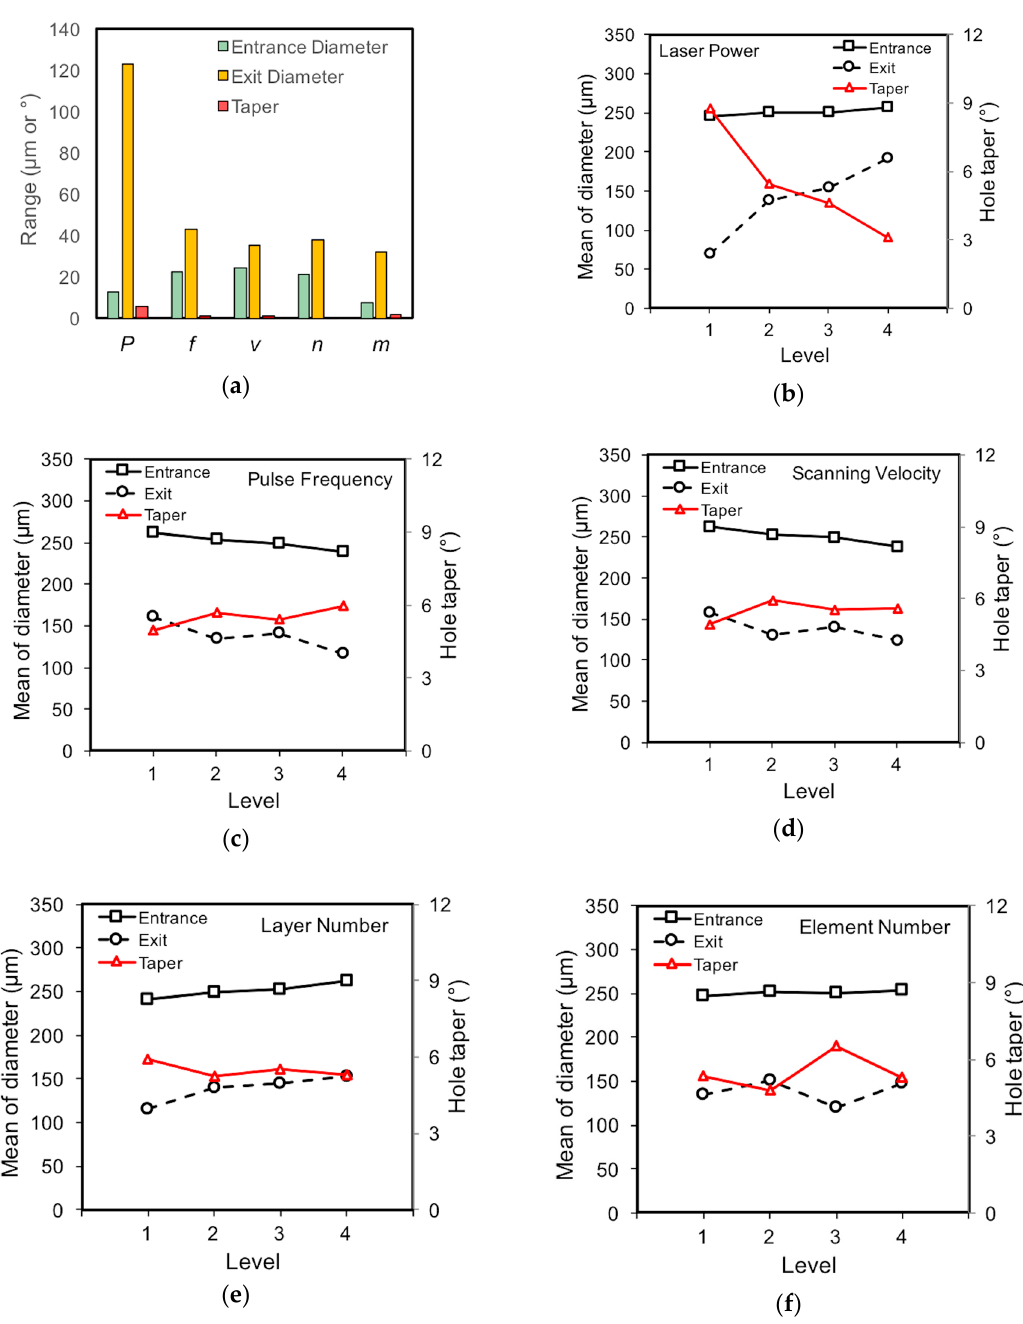
Figure 8. Effects of processing parameters on chemical-assisted trepanning results, where ( a ) is the range analysis result, and ( b – f ) correspond to the laser power, pulse frequency, scanning velocity, layer number, and element number, respectively.